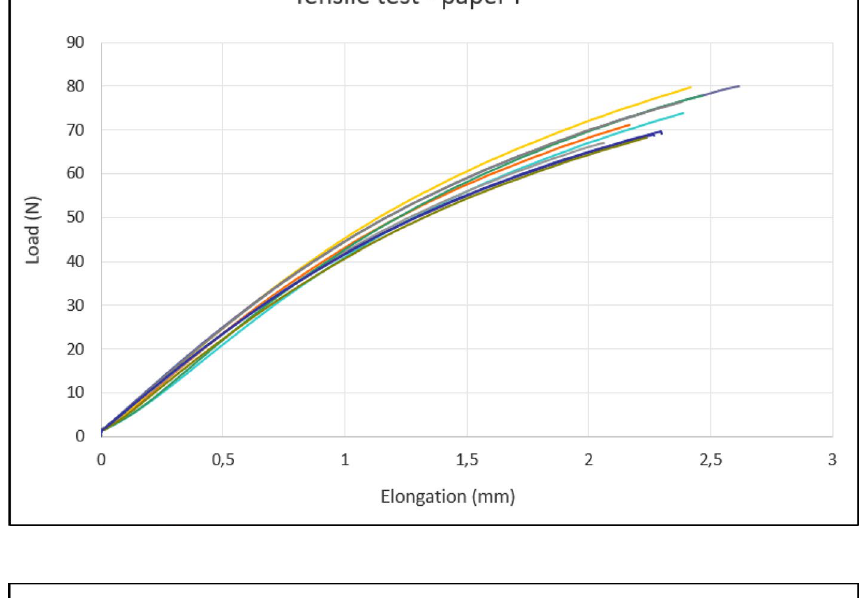
Fig. 41 Force elongation curves of individual specimen of paper